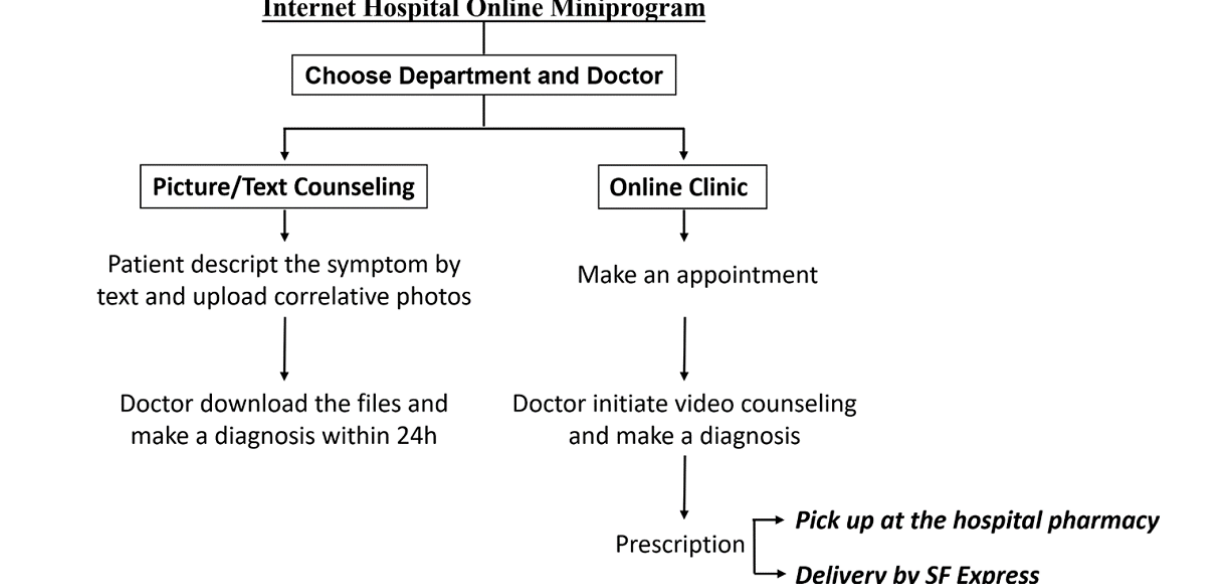
Figure 1. Online workflow of the internet hospital.